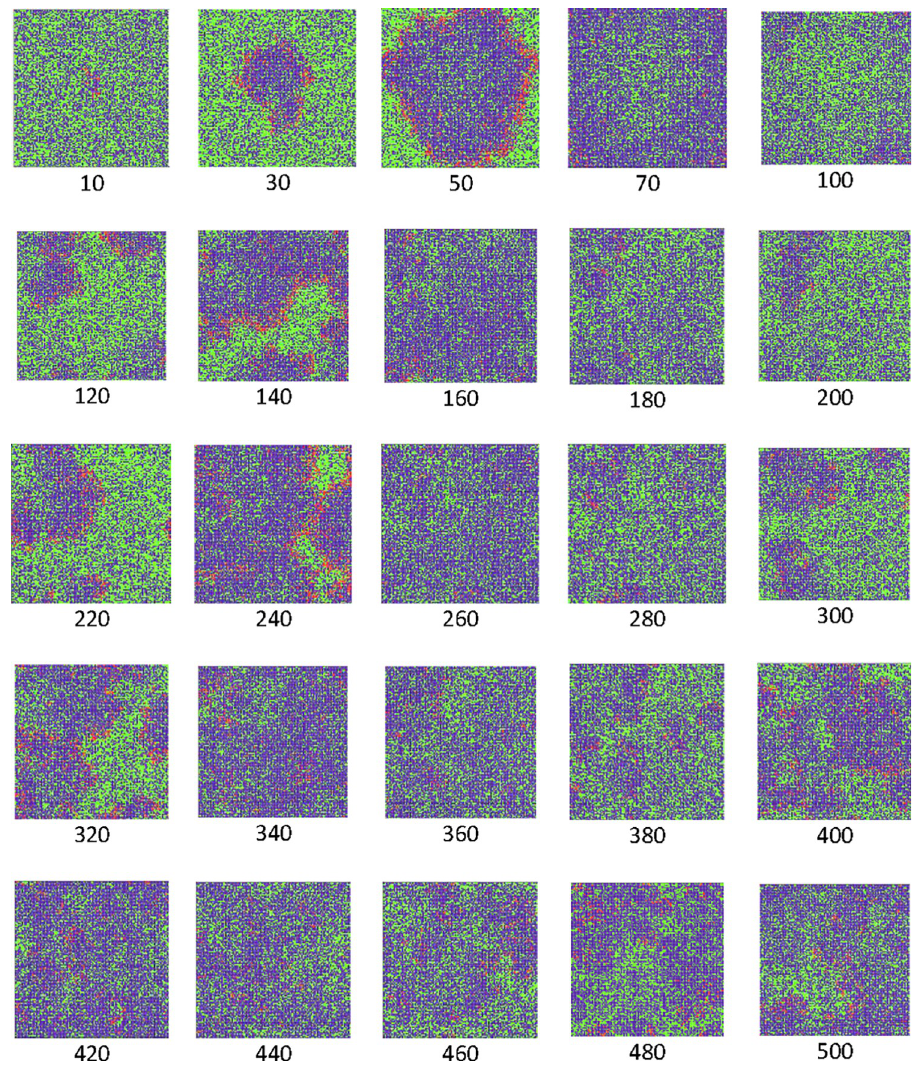
Fig 11. The snapshots at different time steps for the case of P I = 1, P T = 0.4, P H = 0.4, and P D = 0.01. Healthy, infected, and T cells are shown in green, red, and blue,